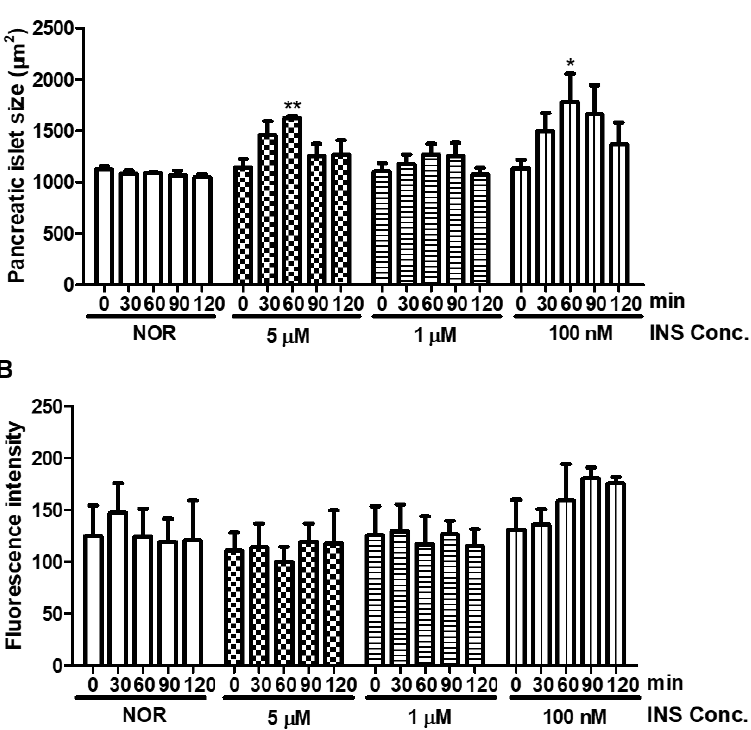
Figure 1. Changes in pancreatic islet following insulin (INS) treatment. ( A ) Dose- and time-dependent changes in pancreatic islet size caused by insulin were analyzed using Focus Lite software ( n = 20). (*) p < 0.05 and (**) p < 0.01; compared to 0 min. ( B ) Fluorescence intensity of the pancreatic islet following insulin treatment.